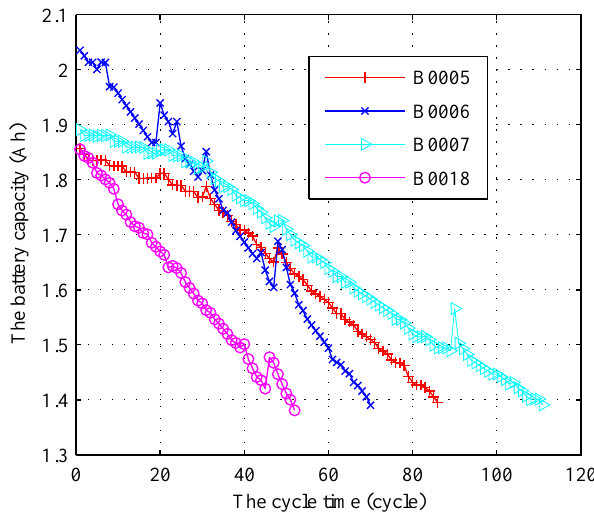
Figure 6. The transformed degradation